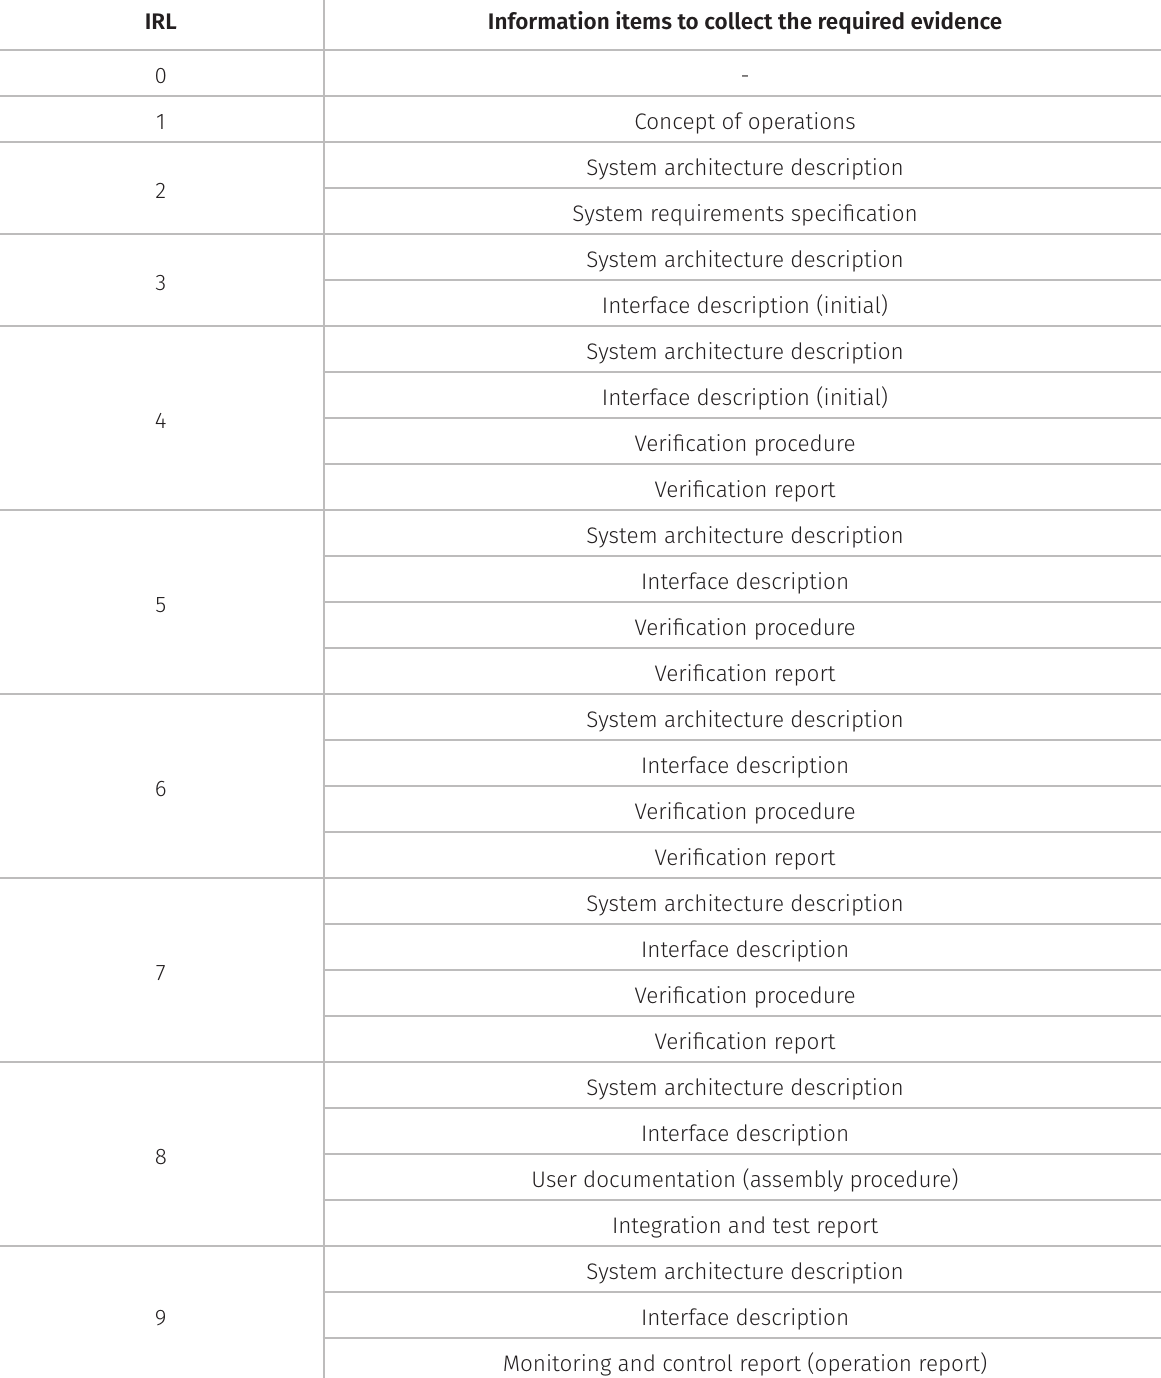
Table IV. The proposed set of information items for each Integration Readiness Level. IRL Information items to collect the required